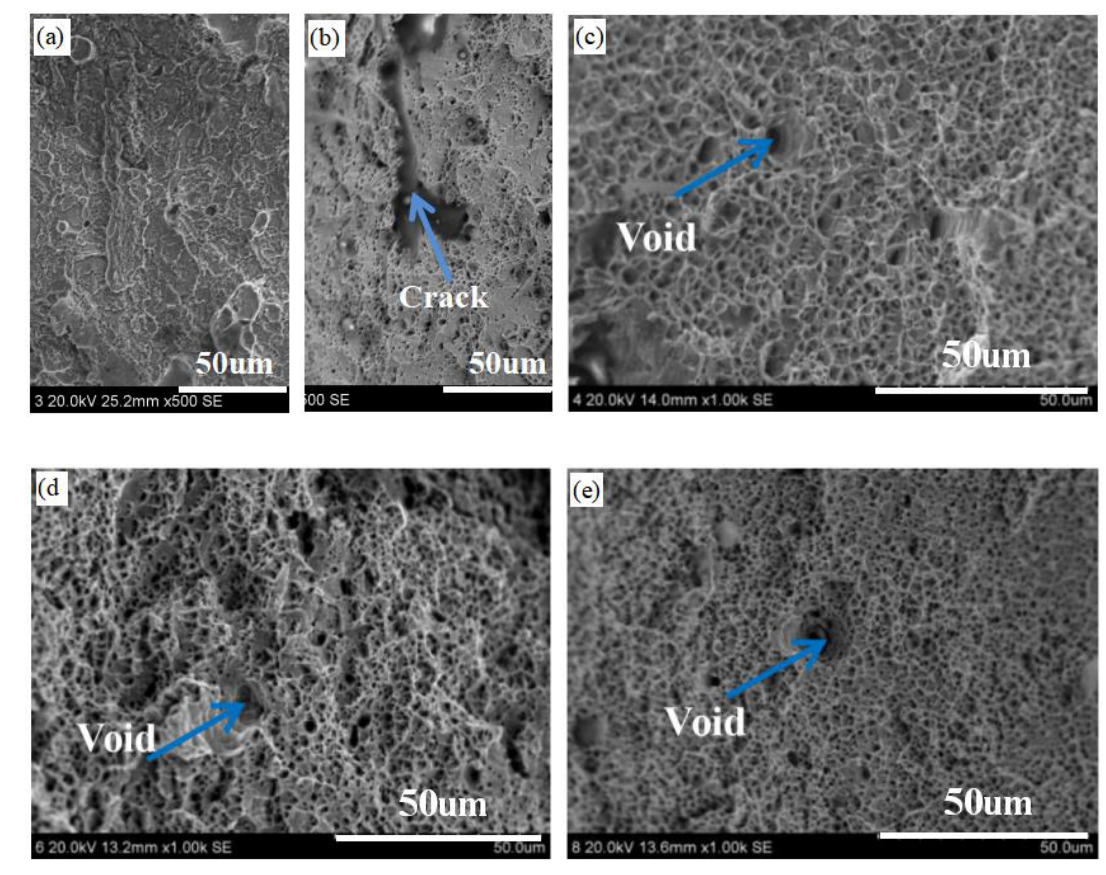
Figure 13. Scanning electron microscopy photos of the fracture surface of the specimen: ( a ) flat fracture surface of 316 L with 1045; ( b ) brittle fracture with dimple gliding fracture of 316 L with 1045; ( c ) 316 L with 1045 under preheating; ( d ) 316 L with P20, ( e ) 316 L with P20 under preheating.